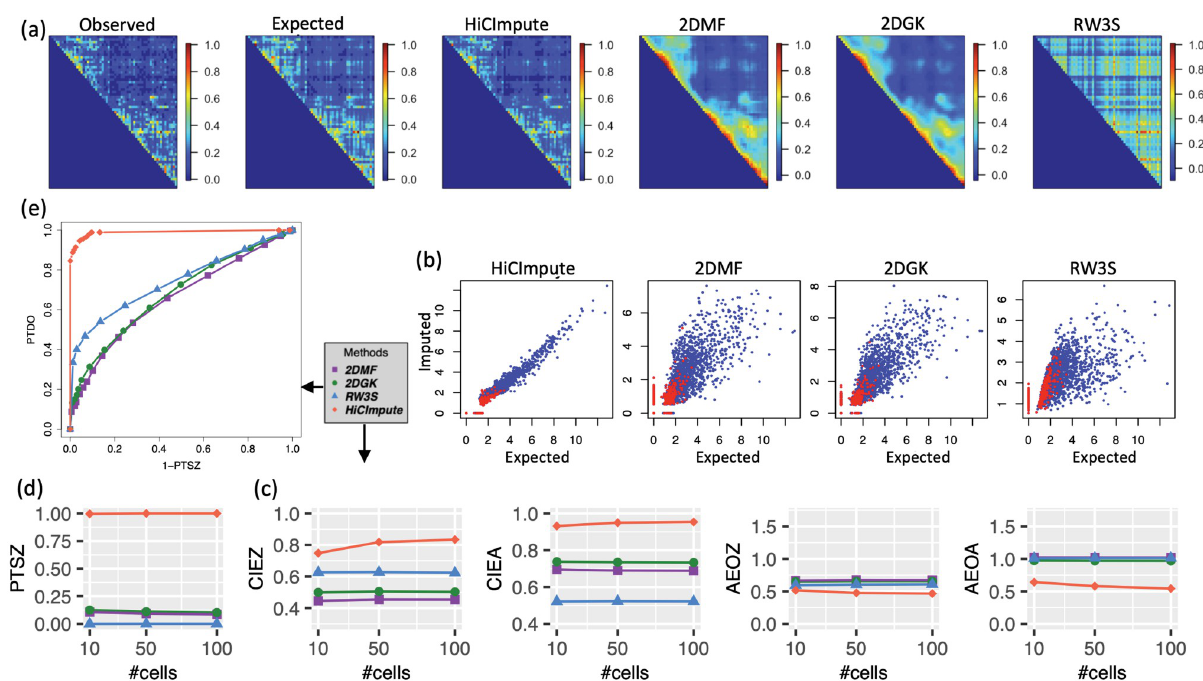
Fig 2. Comparison of results from HiCImpute for data quality improvement with 2DMF, 2DGK, and RW3S for T1 cells at 4K sequencing depth. Ordering of the subfigures is clockwise. (a) Heatmaps of the first single cell showing the observed and true (expected) 2D matrix images as well as the results from HiCImpute and three comparison methods; (b) Scatterplots of Extected Versus Imputed (SEVI plots) for HiCImpute and the comparison methods—the red dots represent the observed zeros, which contain both true SZs (expected = 0) and DOs; (c) aggregate results (over single cells) based on several evaluation criteria; (d) Proportion of true SZs correctly detection averaged over single cells; (e) ROC curves accounting for both PTSZ and PTDO (with AUC = 0.98 compared to 0.66, 0.68, and 0.74 for 2DMF, 2DGK, and RW3S, respectively).